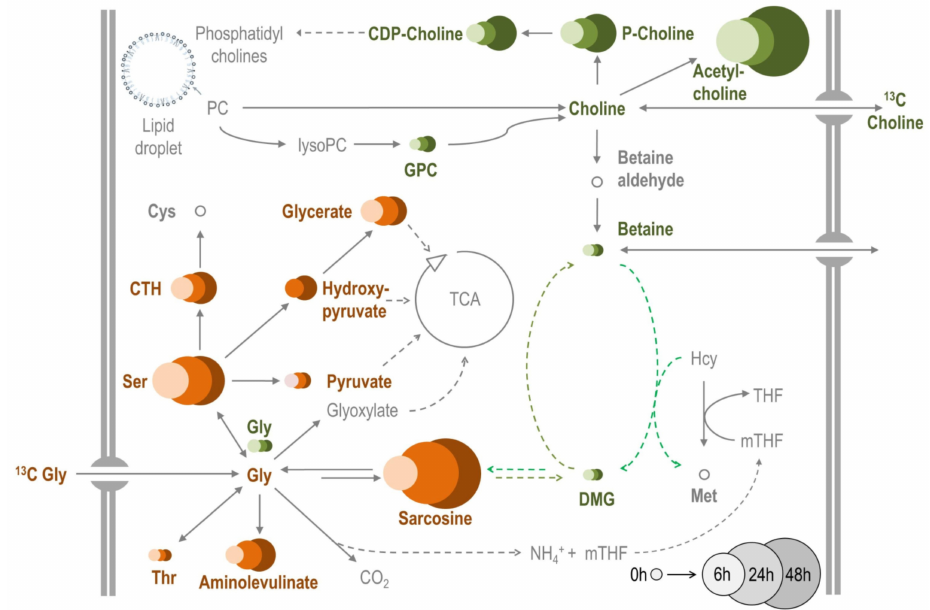
Figure 7. Fluxomics of potential metabolic precursors of betain in C. costata larvae. The map shows the metabolic destiny of two 13 C-labelled compounds ( 13 C-glycine, brown circles; 1,2- 13 C2 choline chloride, green circles) added to the diet of 15 d-old non-diapause (LD) larvae. The larvae were fed on these diets for 6 h, 24 h, or 48 h (6 h is the smallest and lightest circle on the left of the triplet) after which they were processed and analyzed using LC-HRMS metabolomic platform (for more detail, see Materials and Methods). The results are expressed for each metabolite as a percentage of the peak area of 13 C-form (subtracting the native occurrence of 13 C-carbon) relative to 12 C-form (100% is the 0 h small circle in the legend). The size of circles is proportional to the percentage of the 13 C-form. For reference to enzymes (arrows), see Figure